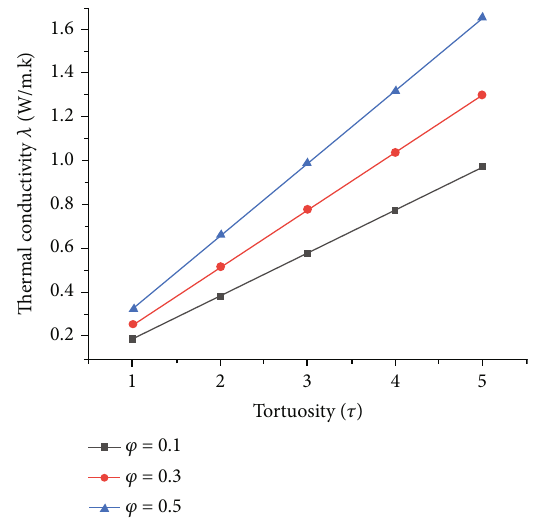
Figure 18: Relationship between thermal conductivity λ and tortuosity τ of the detailed volume-weighted average REV model with di ff erent moisture percentage ϕ .